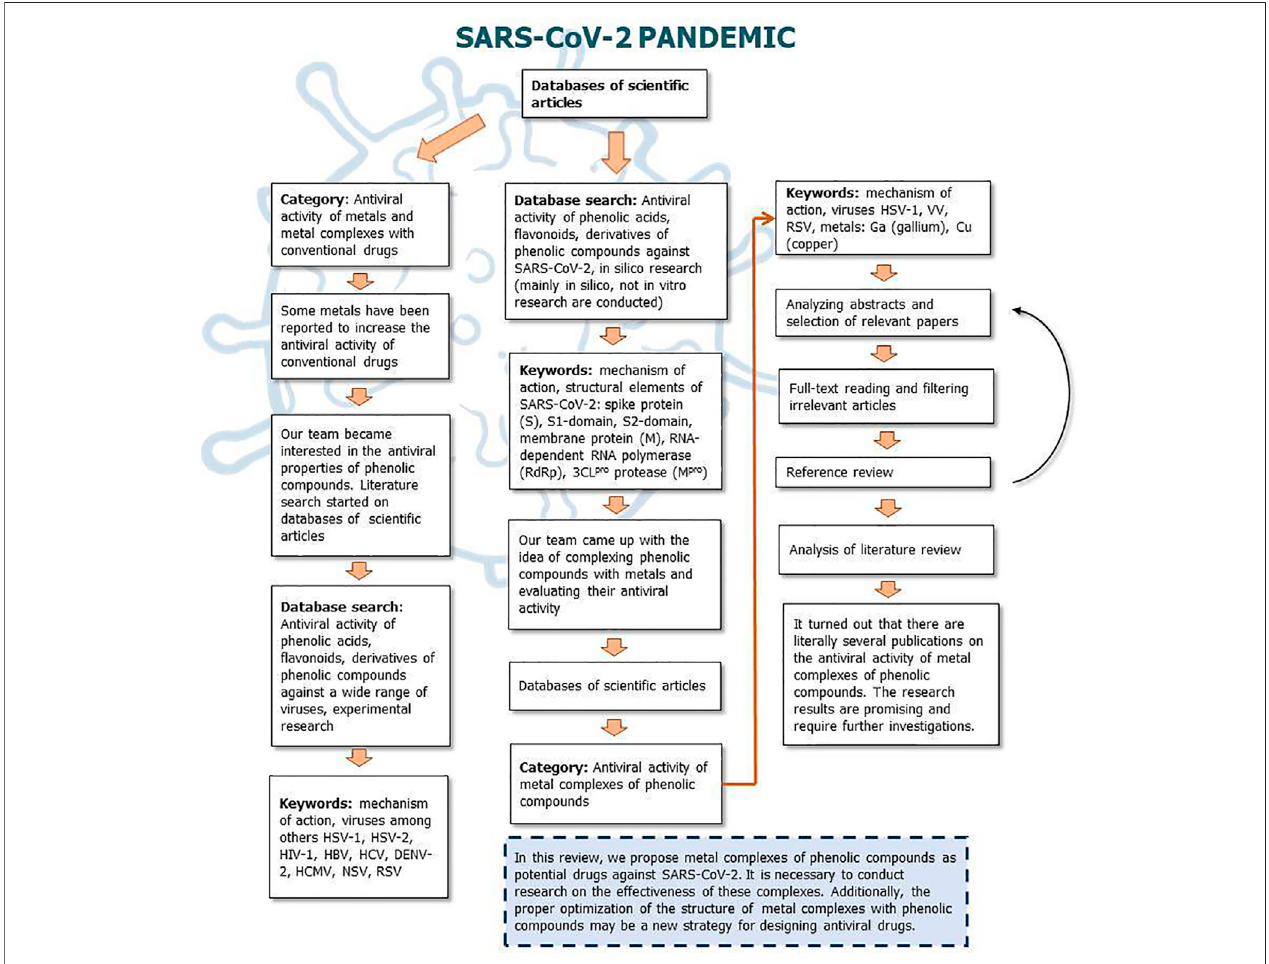
FIGURE 10 | The fl ow diagram which show our strategy for literature survey (part II) based on Ivanov et al. (2019).